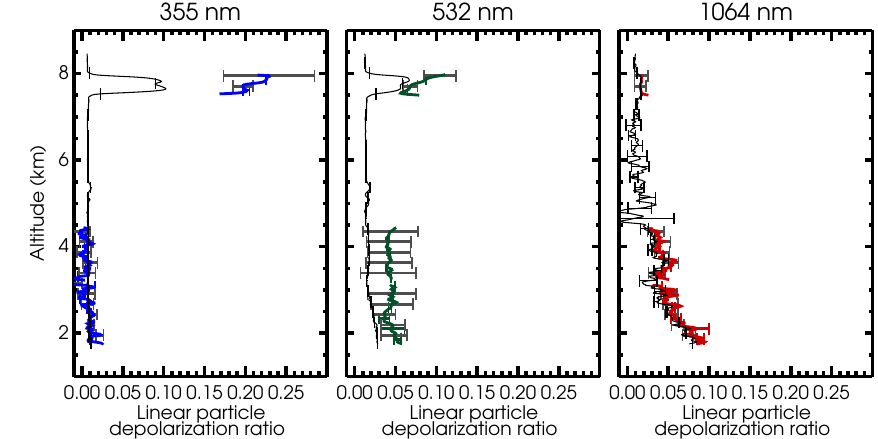
Figure 14. Line plots illustrating the volume and linear particle depolarization ratio profile for the HSRL-2 measurements at 19:18UT (19.3UT) on 17 July 2014. Error bars and resolutions as described for Fig.